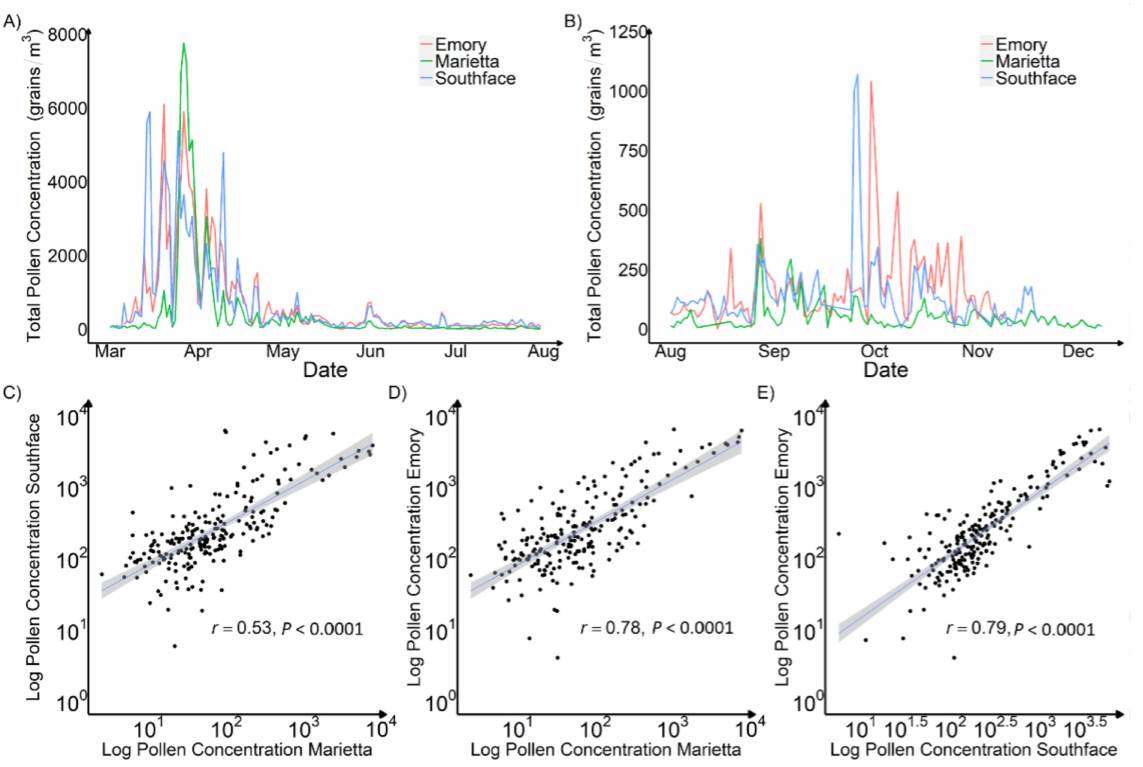
Figure 5. Time Series Plot and Scatter Plot of Daily Pollen Concentration Measured by APS-300 in Marietta, Southface, and Emory in 2020. Plot ( A ) is a spring peak and off-peak pollen season time series plot. Plot ( B ) is a fall peak and off-peak pollen season time series plot. Plot ( C ) is a scatter plot between measurements at Marietta and Southface. Plot ( D ) is a scatter plot between measurements at Marietta and Emory. Plot ( E ) is a scatter plot between measurements at Southface and Emory. The peak pollen season was from late March to